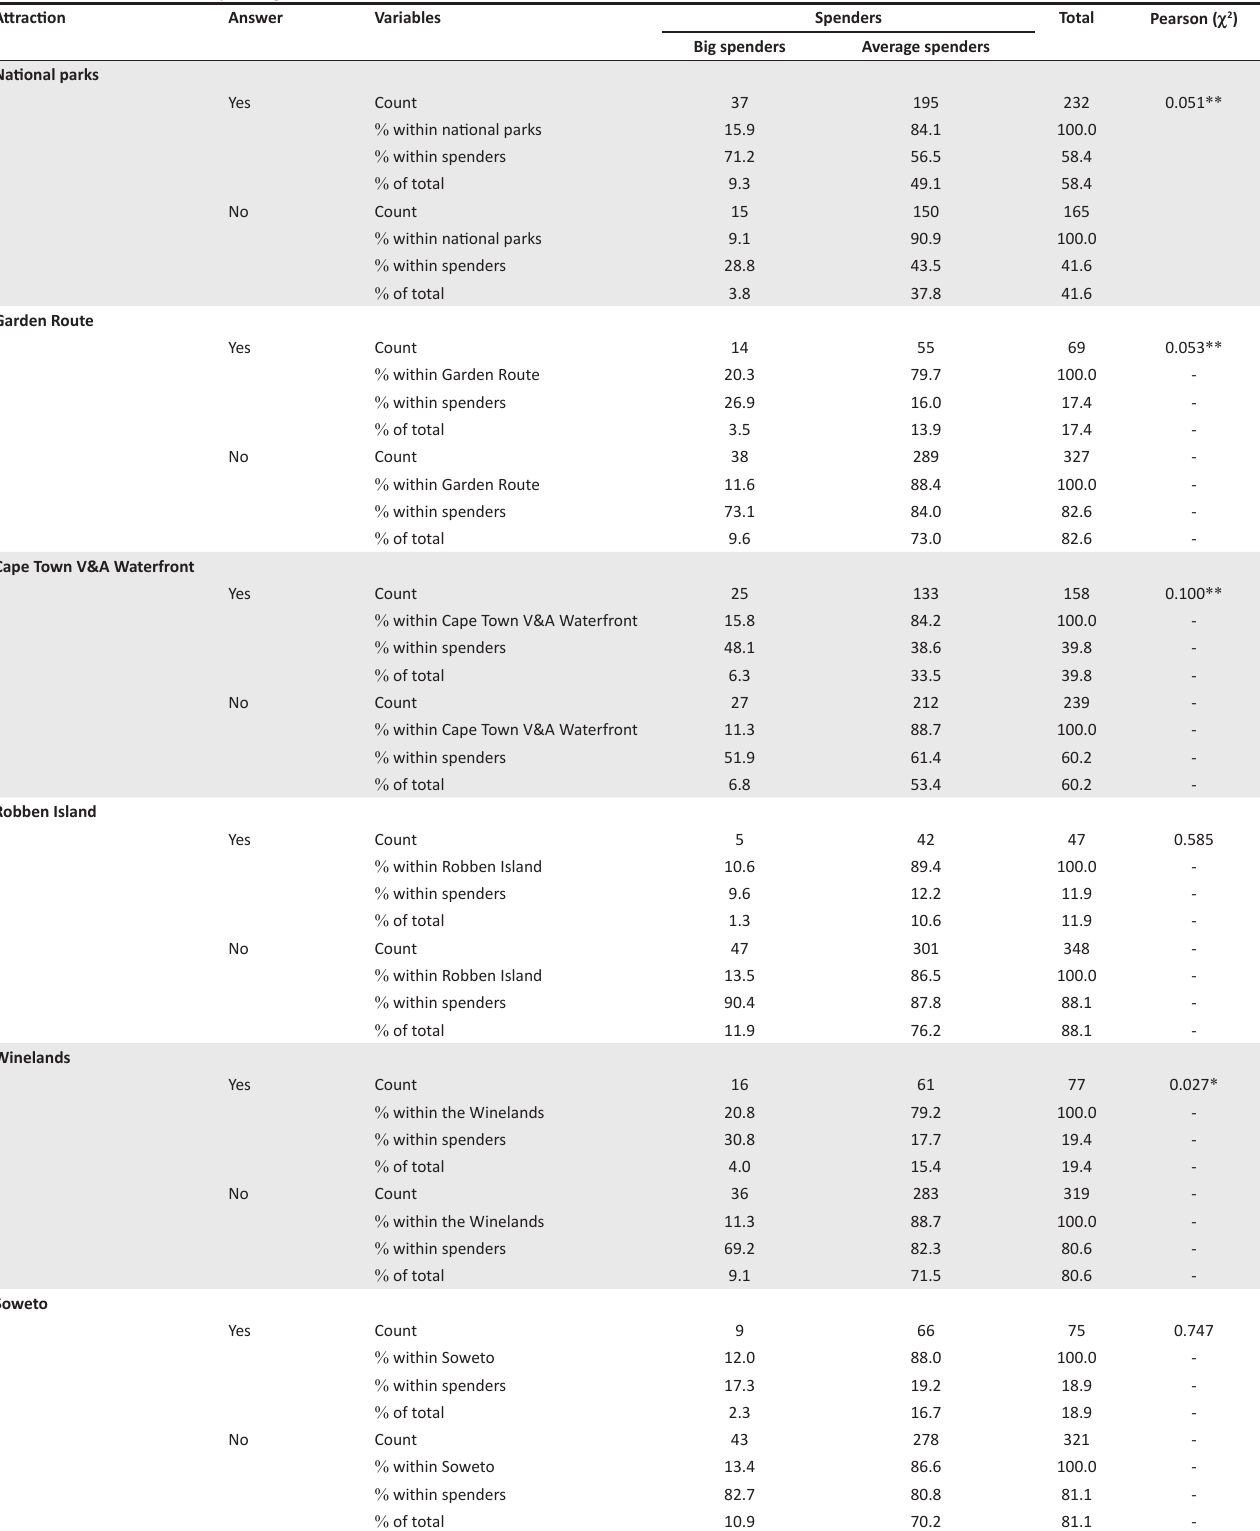
TABLE 7: Cross-tabulation of spending habits. Attraction Answer Variables National